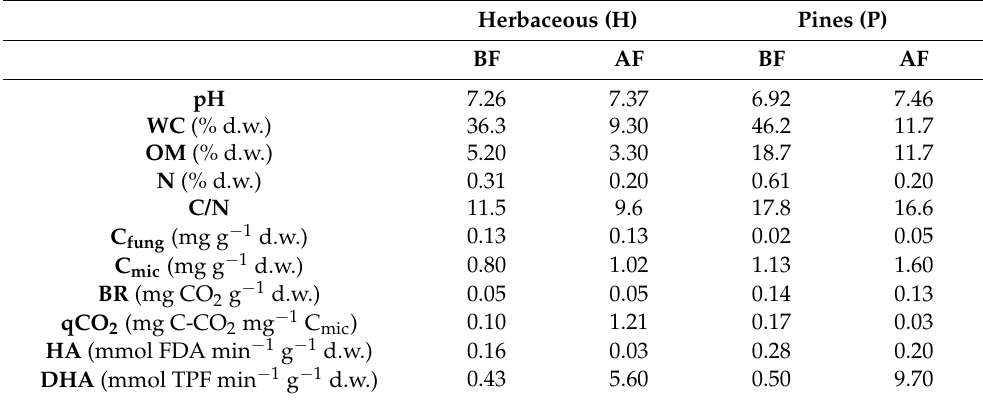
Table 4. Values of physico-chemical and biological parameters of the soils collected before and after the fire under herbaceous and pine specimens.